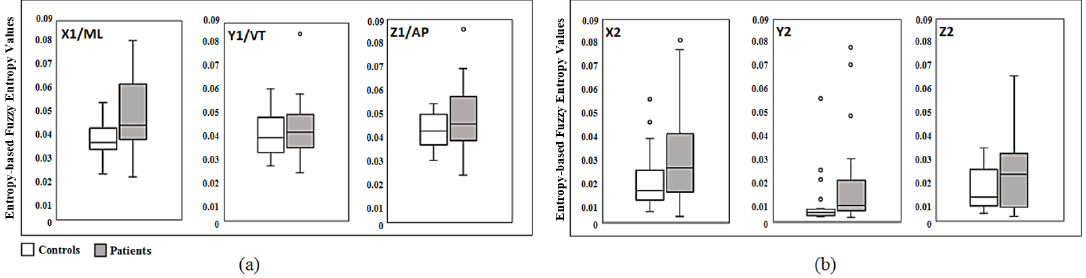
Figure 5. Box-plots of velocity-based Fuzzy entropy results of Trunk test using Sensor 1 ( a ) and Sensor 2 ( b